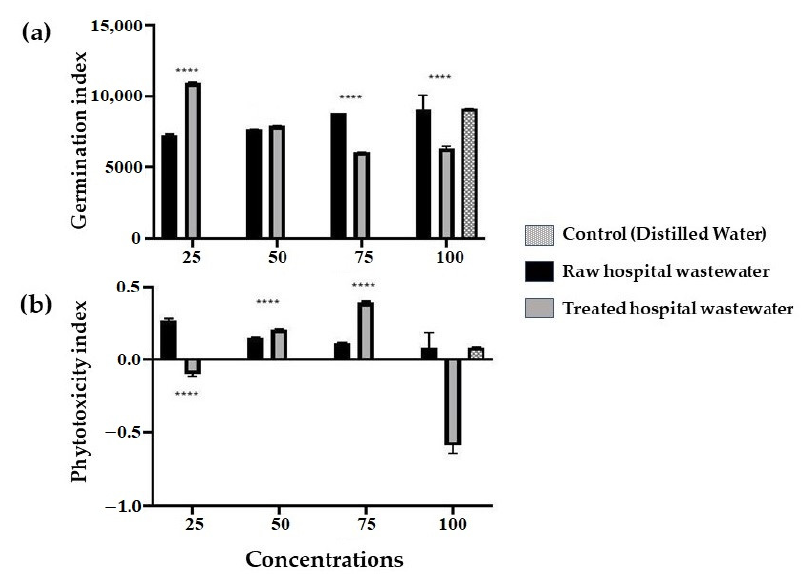
Figure 7. ( a ) Germination indices of Hot pepper seeds grown in untreated and treated hospital wastewaters; ( b ) Phytotoxicity indices of Hot pepper seeds grown in untreated and treated hospital wastewaters. Significance (Welch’s test) between treated and untreated hospital wastewater is indicated by p < 0.0001 ****.